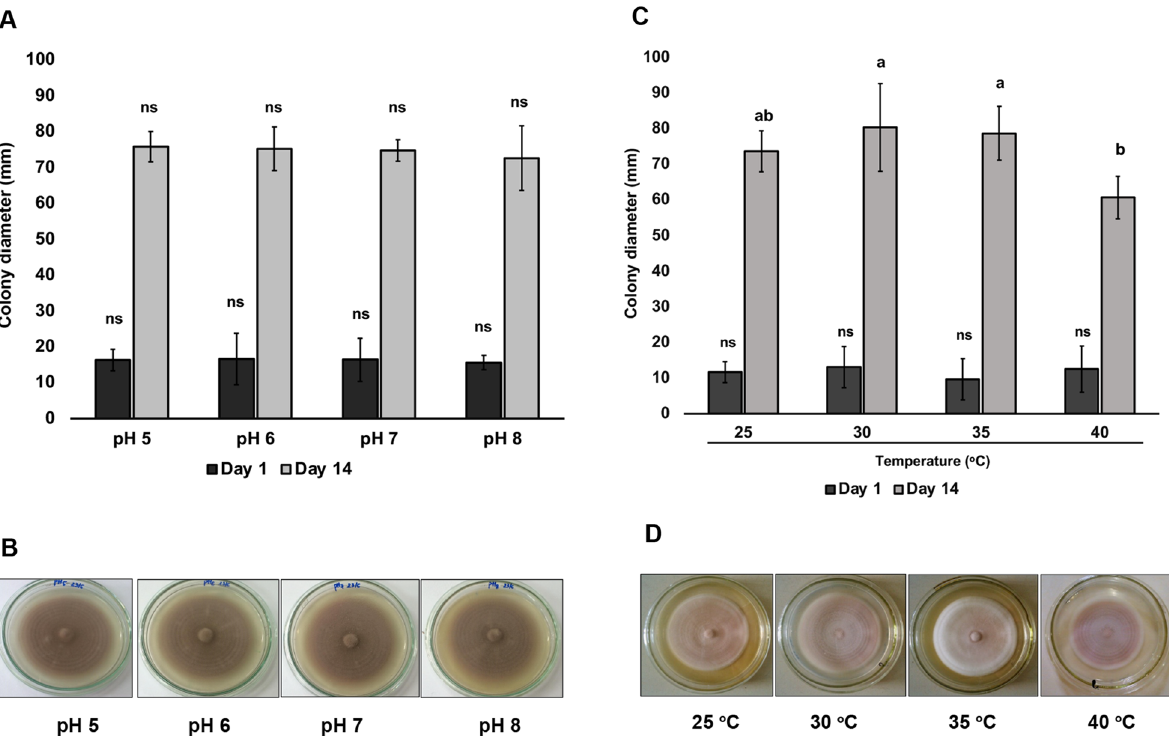
Fig. 3 Effect of pH ( A ) and temperature ( B ) on the growth of Purpureocillium lilacinum PL1 mycelial indicated by radial growth after 4 days of cultivation. C Representative images of P. lilacinum PL1 mycelial on PDA culture medium at different pH value after 14 days of cultivation. D